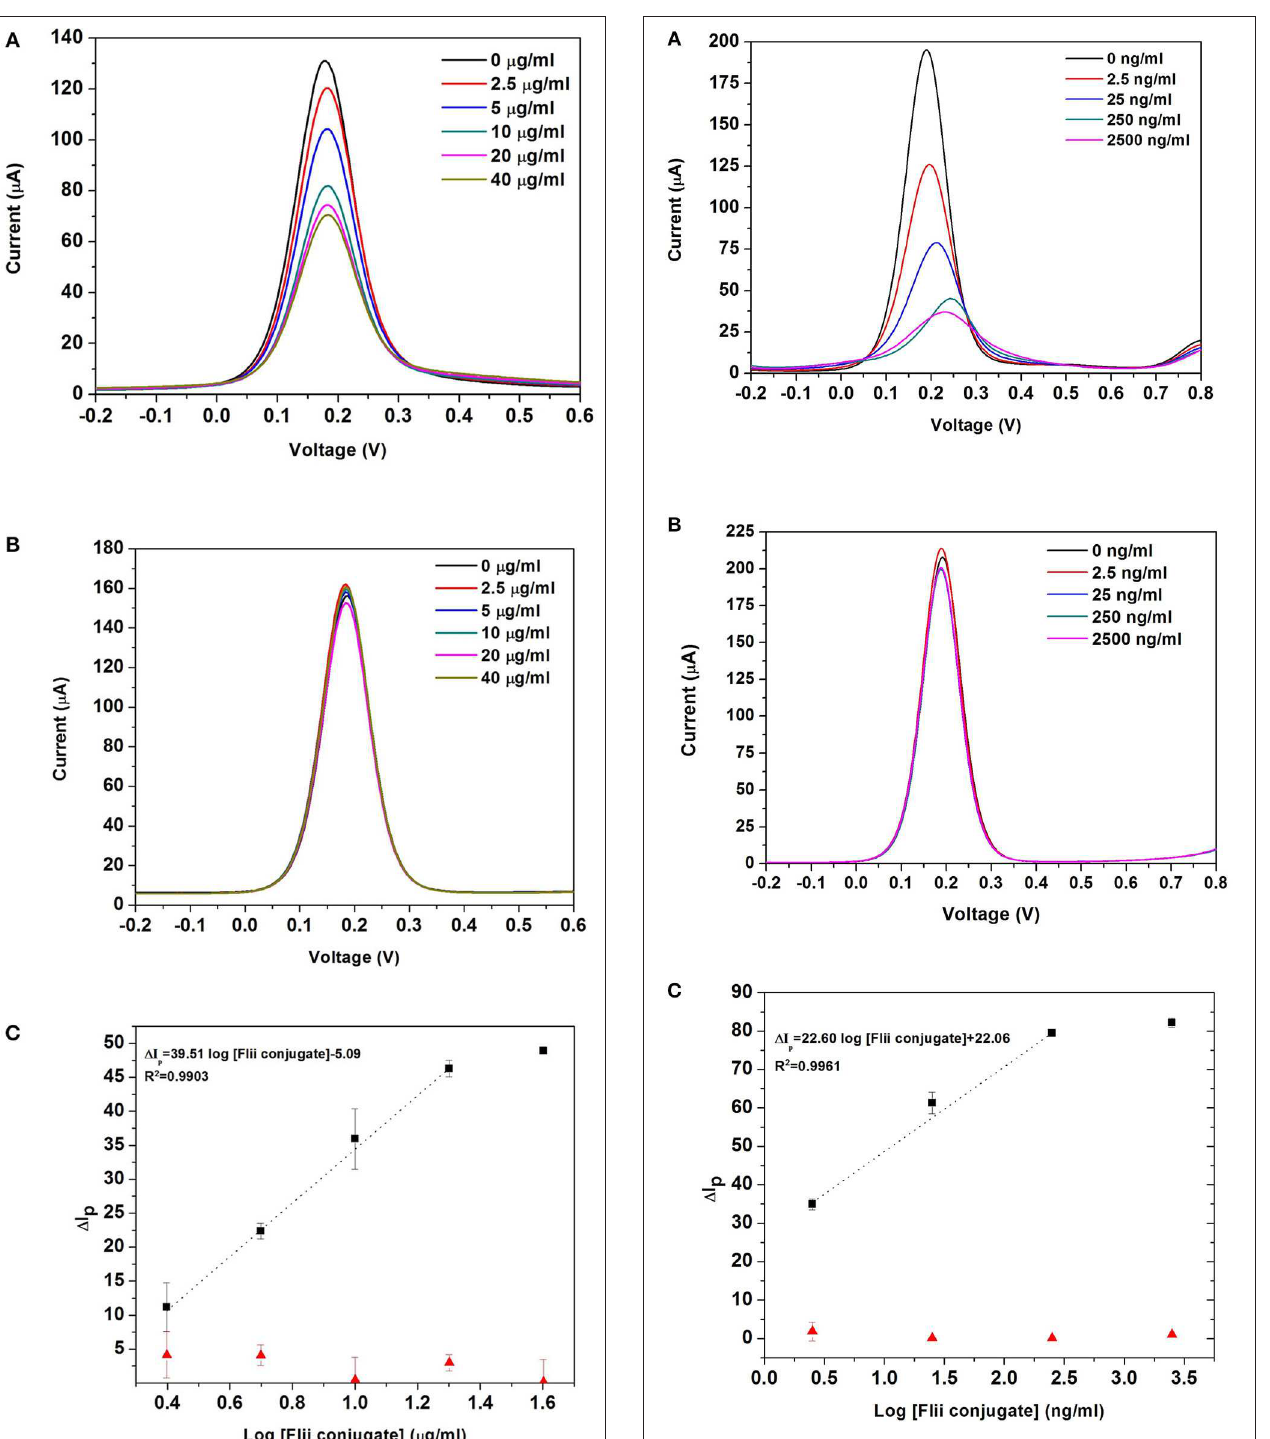
FIGURE 5 | DPV curves obtained with the NAA-based electrochemical immunosensor (A) , and the control sensor (B) when an external magnetic field is applied during the analyte incubation step; dose response curves for the detection of KLH-Flii peptide conjugate plotted using the NAA-based electrochemical immunosensor and control sensor when an external magnetic field is applied during the analyte incubation step (C) . Error bars are calculated as standard deviation from the average of three individual